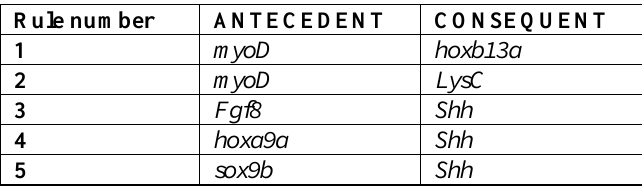
Table 3: An example extracted from the result set using the PPM algorithm (support >= 30% and confidence >= 75%) on the GEMS dataset.